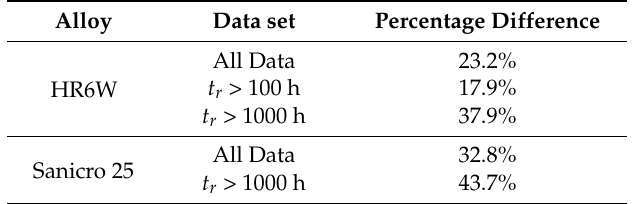
Table 12. Calculated rupture time for the longest test duration percentage